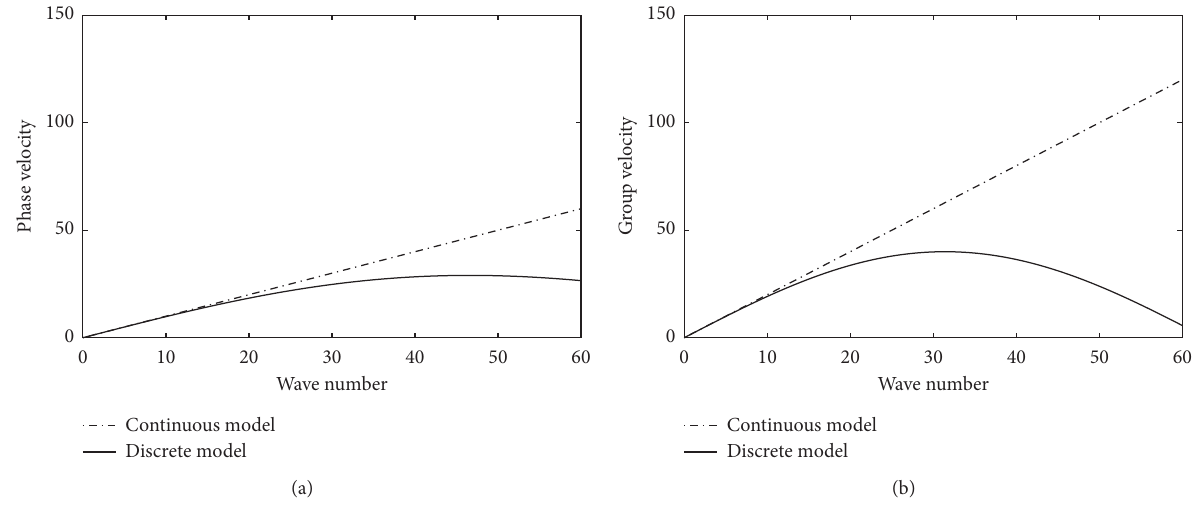
Figure 1: Wave velocity in the Euler–Bernoulli beam ( β � 1, Δ x � 0.05): (a) phase velocity; (b) group